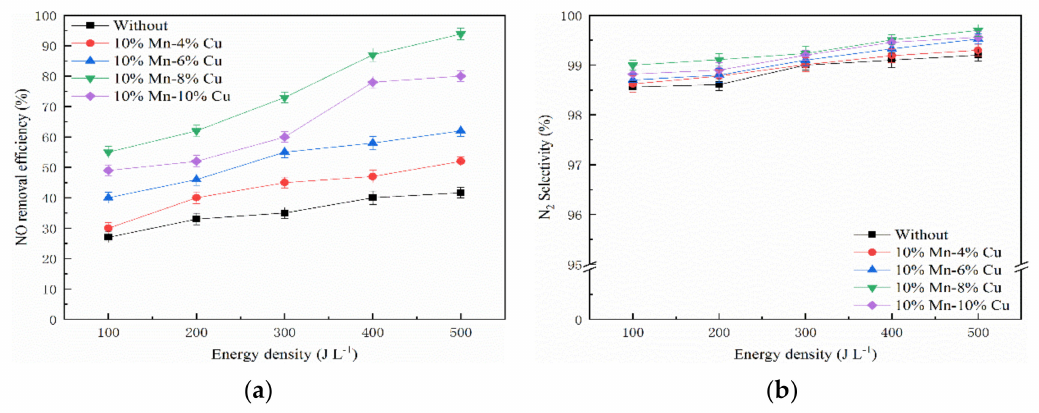
Figure 7. E ff ect of energy density on NO removal e ffi ciency. ( a ) NO removal e ffi ciency and ( b ) N 2